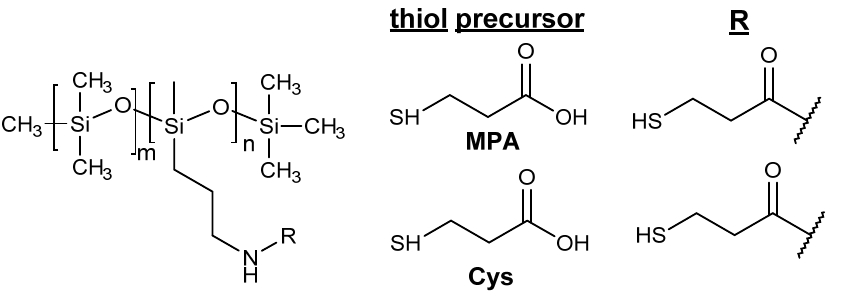
Figure 10. Thiolated silicone oils bearing 3-mercaptopropionic acid (MPA) or cysteine (Cys) pen- dant groups synthesized by Partenhauser et al. [72].